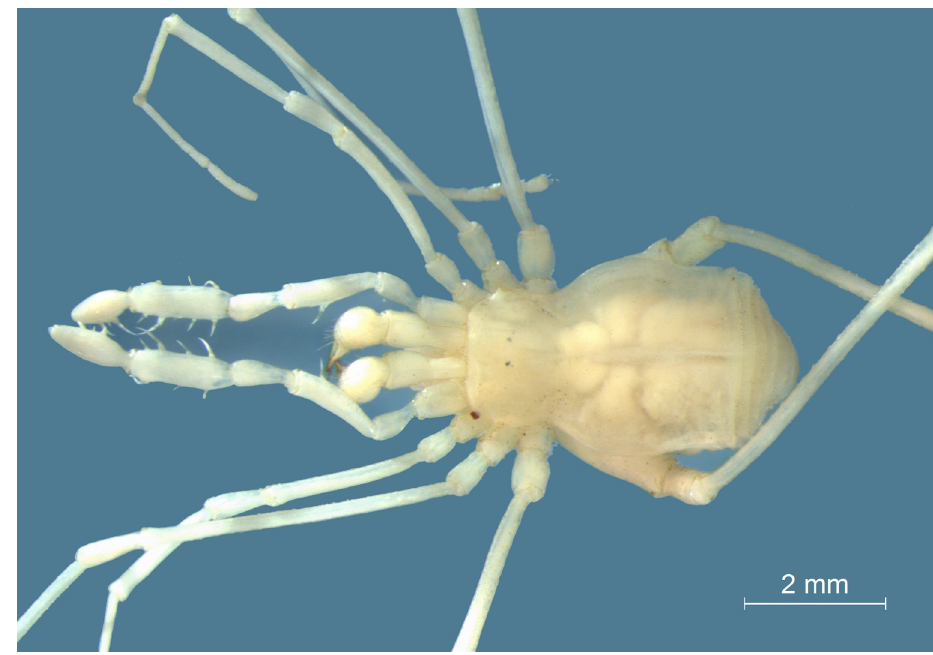
Fig 1. Otilioleptes marcelae gen. nov., sp. nov. Paratype male (FML-OPIL 00218), dorsal view. Photo: Abel Pe´rez- Gonza´lez.